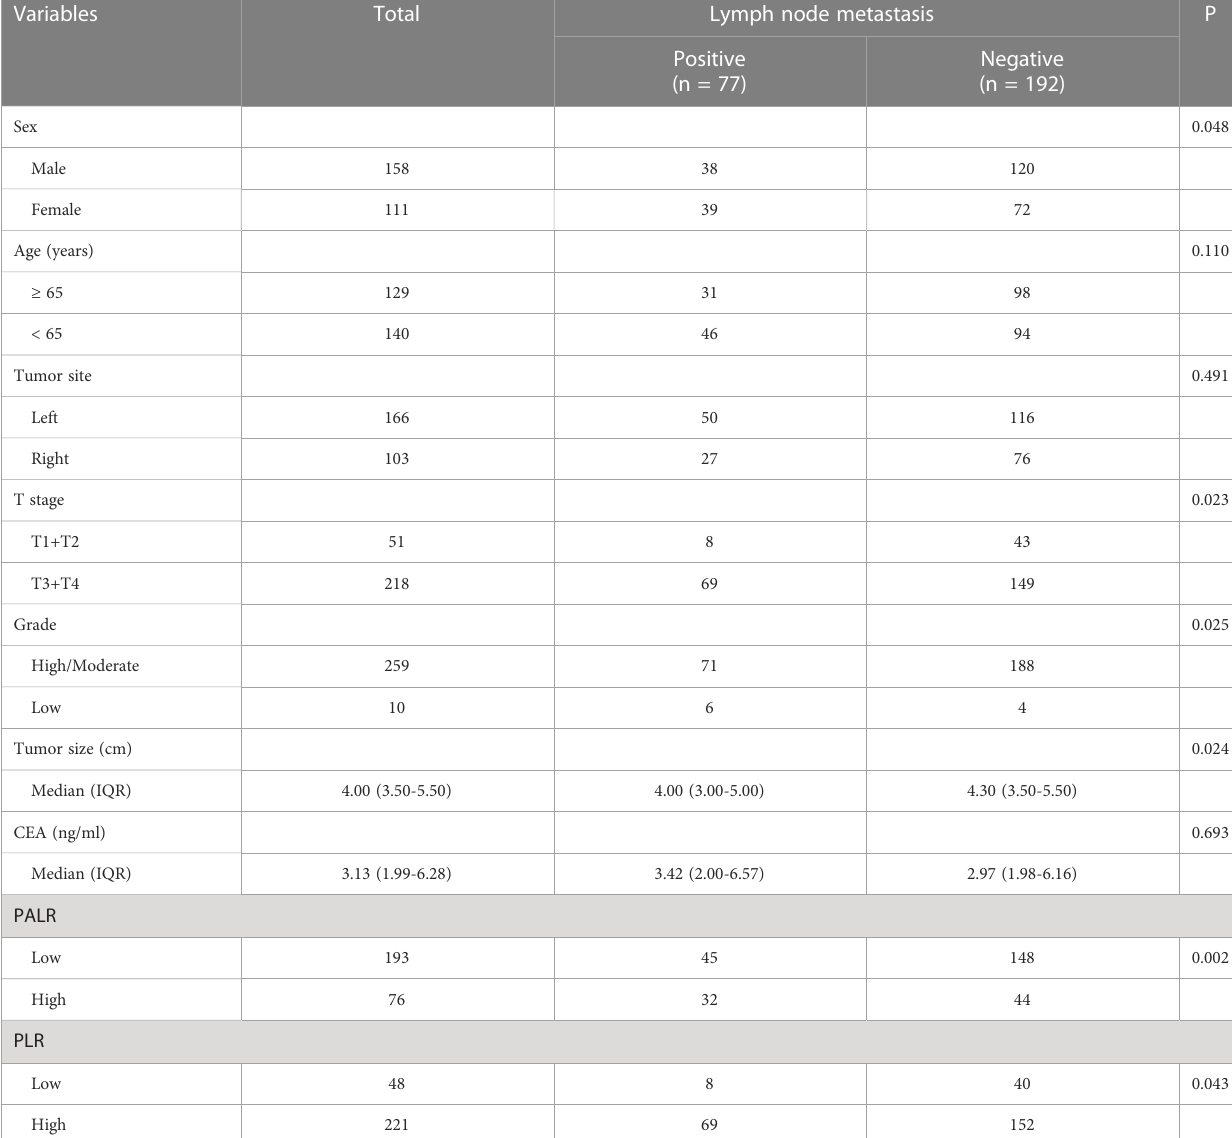
TABLE 1 Clinicopathological variables of patients with cN0 colon